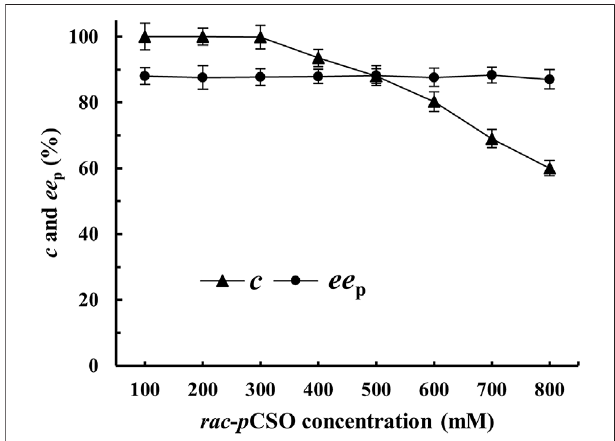
FIGURE 4 | The enantioconvergent hydrolysis of rac-p CSO at 100 – 800 mM in the 4% (v/v) Tween-20/phosphate buffer system (100